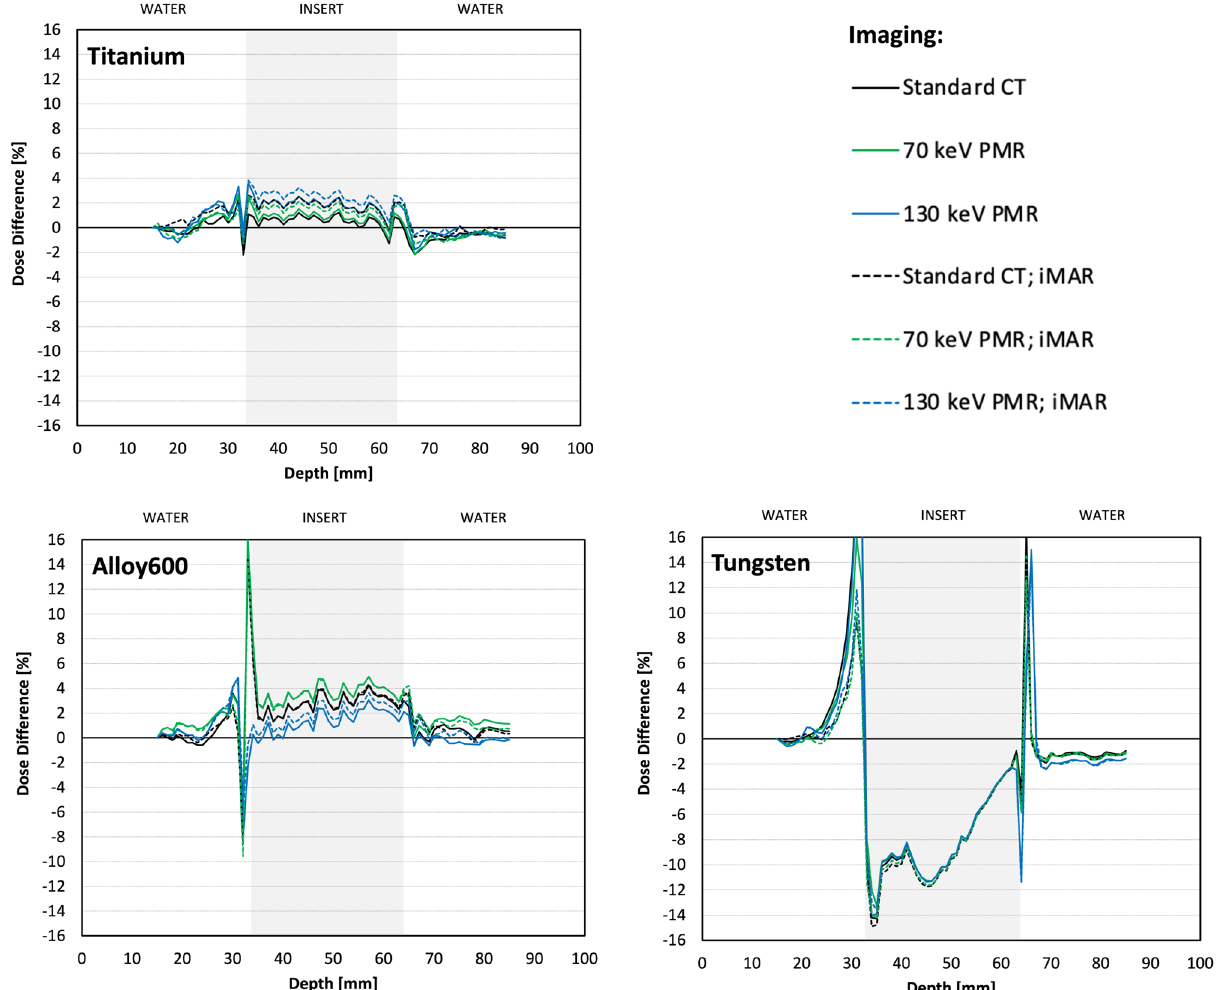
Figure 6. Differences between PDDs obtained from Monte Carlo simulations performed for TPS condition and PDDs obtained from TPS calculations using Acuros XB algorithm based on dose-to-medium approach on different CT reconstructions for titanium, alloy 600, and tungsten inserts,